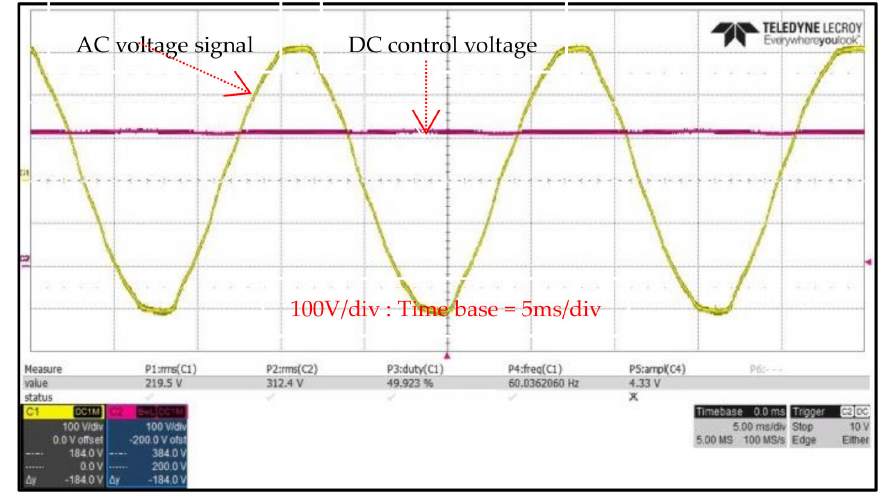
Figure 7. Full wave bridge rectifier resultant output